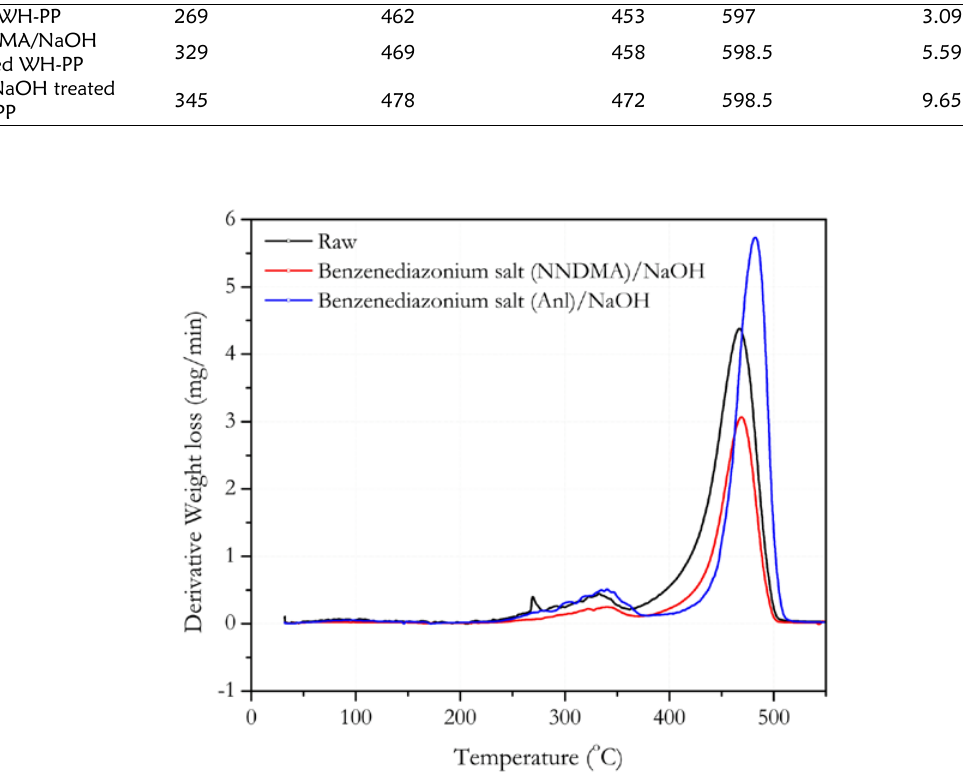
Figure 1: Derivative weight loss of 35 wt% WH-PP composites as a function of temperature